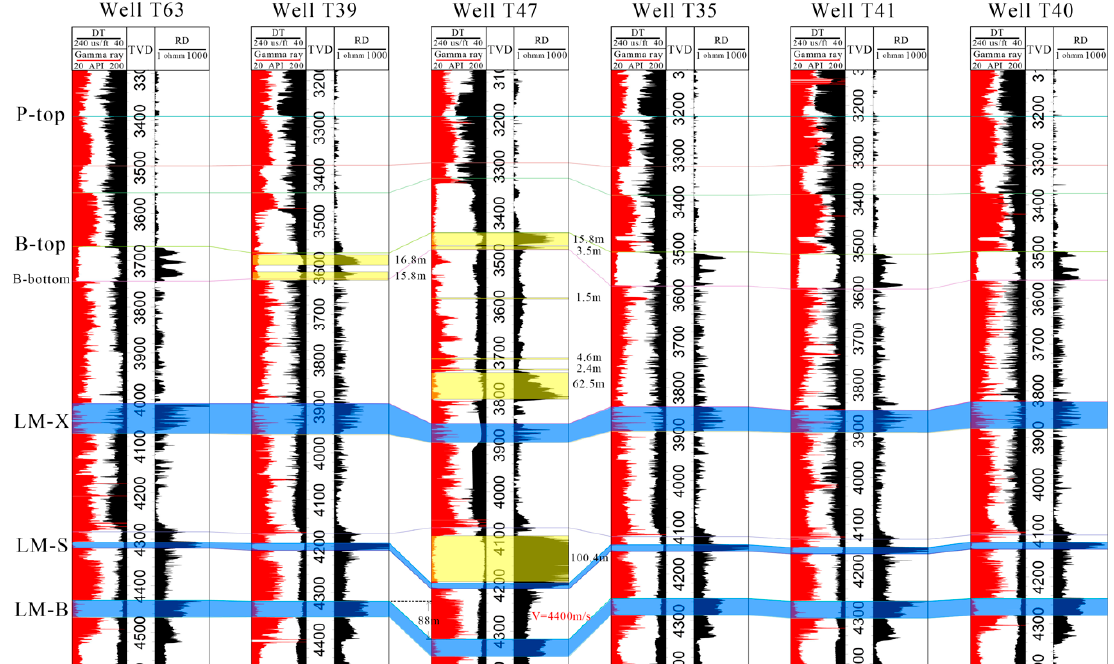
Figure 7. Log profile flattened along the Permian–Triassic (PT) boundary (P-top). Yellow color stands for mafic magmatic rocks. Blue color stands for limestones, which are Xiaohaizi limestones (LM-X), Standard limestones (LM-S) and bioclastic limestones (LM-B), respectively. The top of bioclastic limestones (LM-B) is abbreviated as LM-Btop in the text.